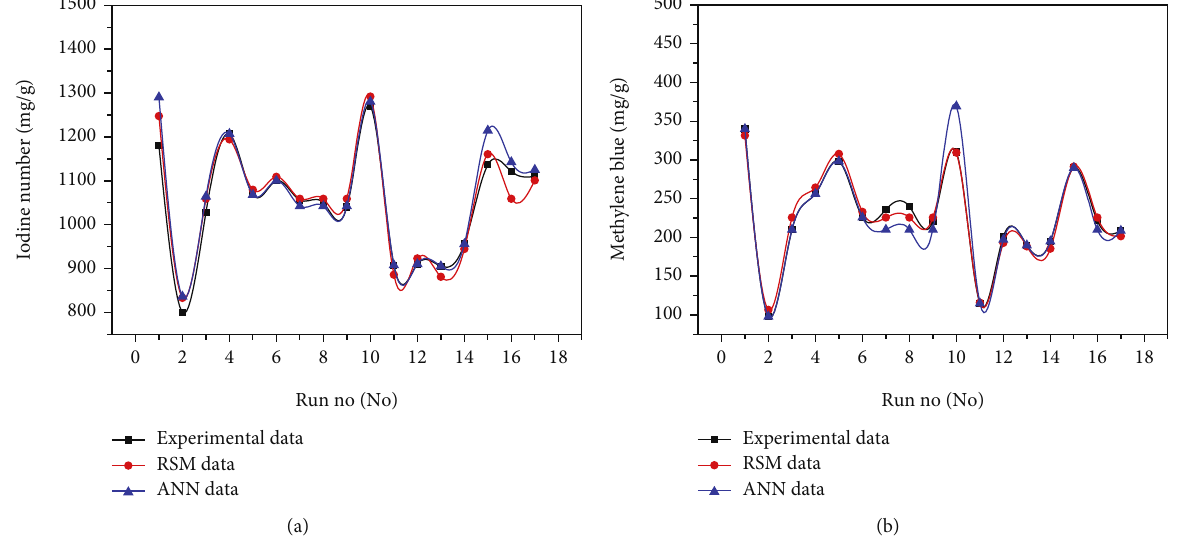
Figure 8: Comparison of experimental, RSM, and ANN-predicted values of (a) iodine number and (b) methylene